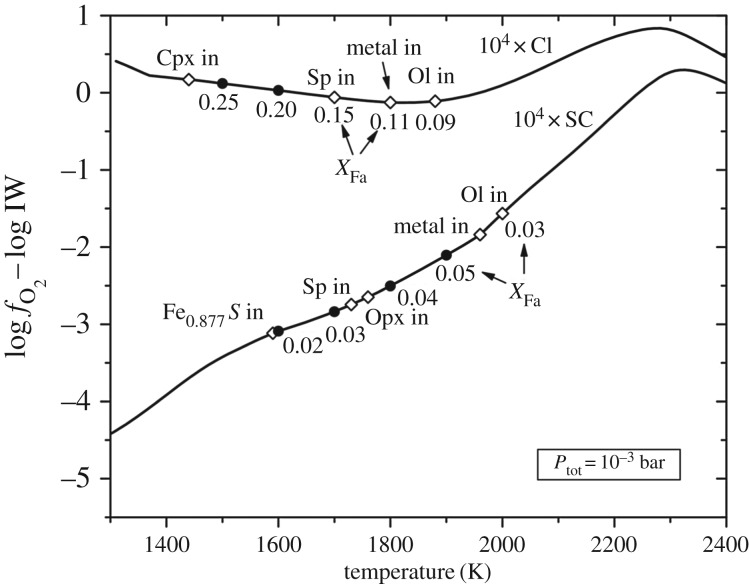
Logarithm of the oxygen fugacity relative to the iron-wüstite (IW) buffer as a function of temperature in systems enriched in CI and SC dust by a factor of 104 relative to their complementary gas at Ptot=10−3 bar. Symbols and labels are as in [297], fig. 2: open diamonds indicate the condensation temperatures of the phases; filled circles and numbers next to them are the mole fraction fayalite (XFa) in the coexisting olivine. Both the FeO content of the liquid and XFa increase continuously with decreasing temperature in the CI dust-enriched system (reaching XFa=0.25). By contrast, in the SC dust-enriched system, the FeO content of the liquid and XFa reach a maximum [XFa=0.05] at 1960 K, the metal condensation temperature, and then both fall as temperature falls. Sp=spinel; Ol=olivine; Cpx=clinopyroxene; Opx=orthopyroxene (reproduced with permission from [297], fig. 3. Copyright © 2016 John Wiley & Sons, Inc.)